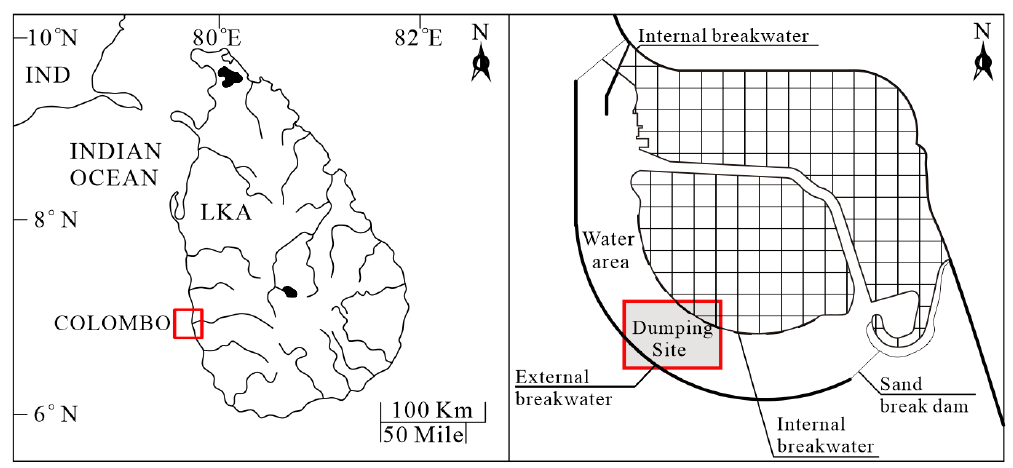
Figure 2. Arrangements of the dumping locations.